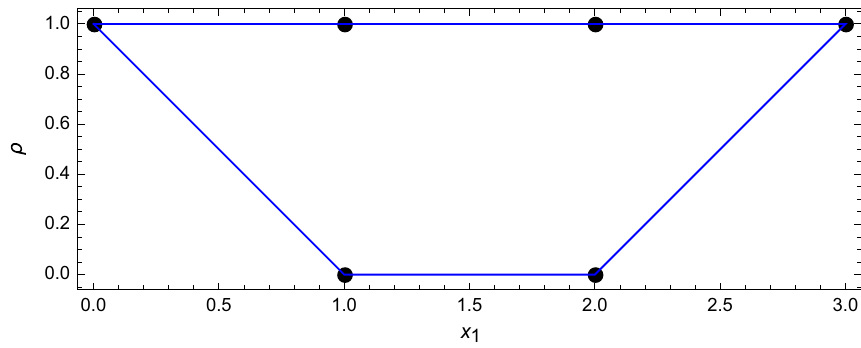
Fig. 2 Convex hull of the projected set of vector exponents